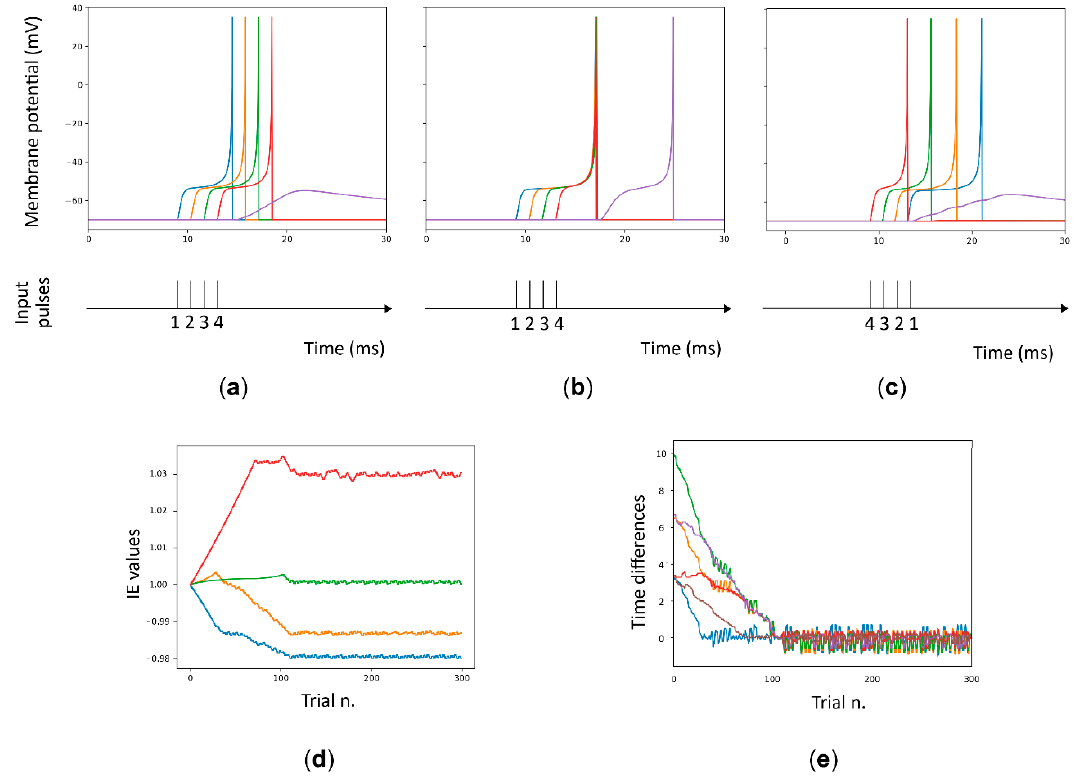
Figure 4. MNSD learning phase. Plot of the training patterns before ( a ) and then ( b ) the MNSD is trained; in the second case the target (red line) generates a spike. ( c ) the trained MNSD is now stimulated with the same pattern timings but different order. This does not allow the target to reach the threshold. Plot of the MNSD training: ( d ) trajectory of the intrinsic excitability parameter ( IE p ) for each delay neuron and ( e ) trajectory of the time difference between two neuron spikes in ms ( ∆ t out ). In the latter figure, during the presentation of the trials, the values progressively tend to zero, indicating that neurons fire together.